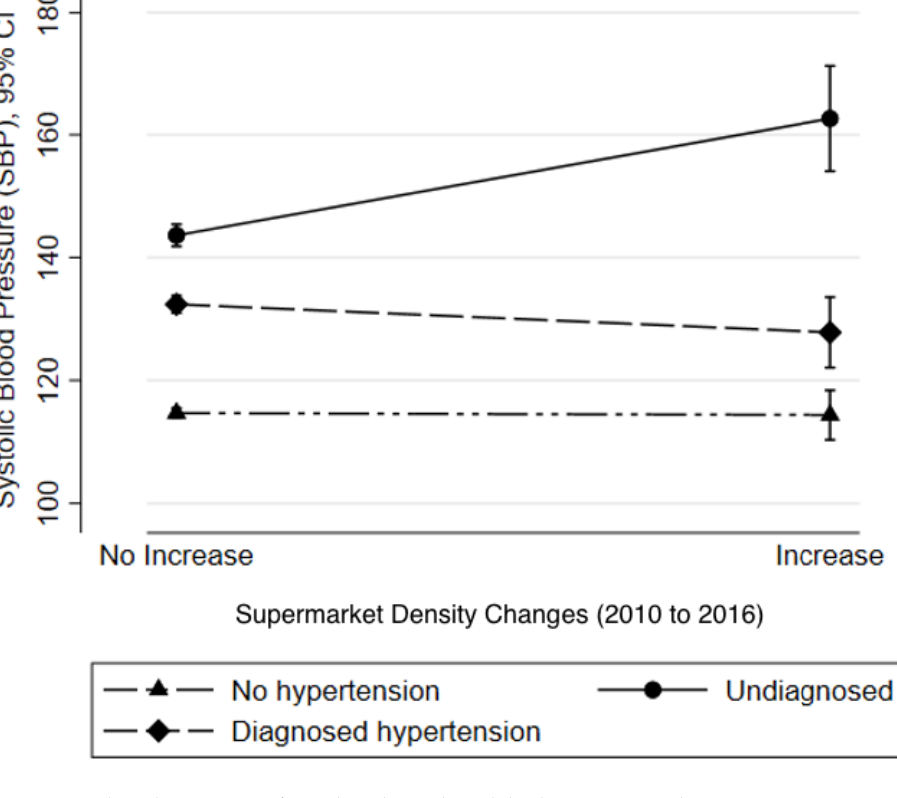
Figure 1. Predicted SBP means from the adjusted model. The association between 6-year supermarket density changes (no increase and increase) and blood pressure varied by hypertension group status (interaction p <